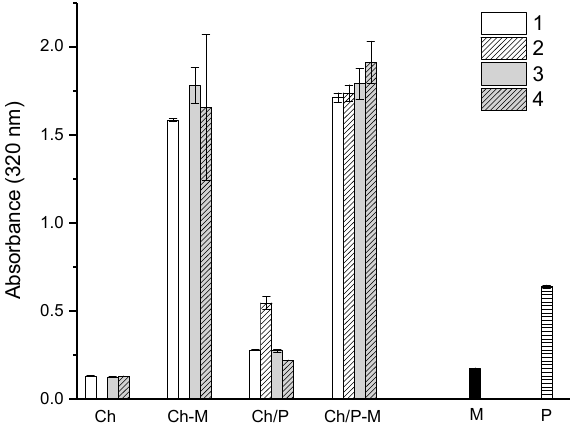
Figure 2. Turbidity profiles of Ch’s (samples 1, 2, 3, 4), Ch-M, Ch/P , Ch/P -M, M (Mucin) and P (phospholipids) solutions after 30 min of interactions. Presented results are average of at least three independent experiments ( n = 3) and are presented as mean ± standard deviation.